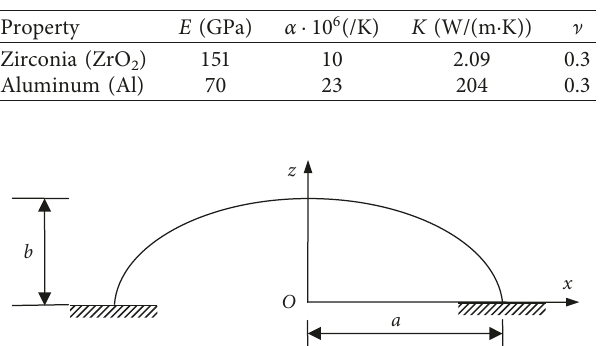
Table 1: Material properties of the FG curved beams.